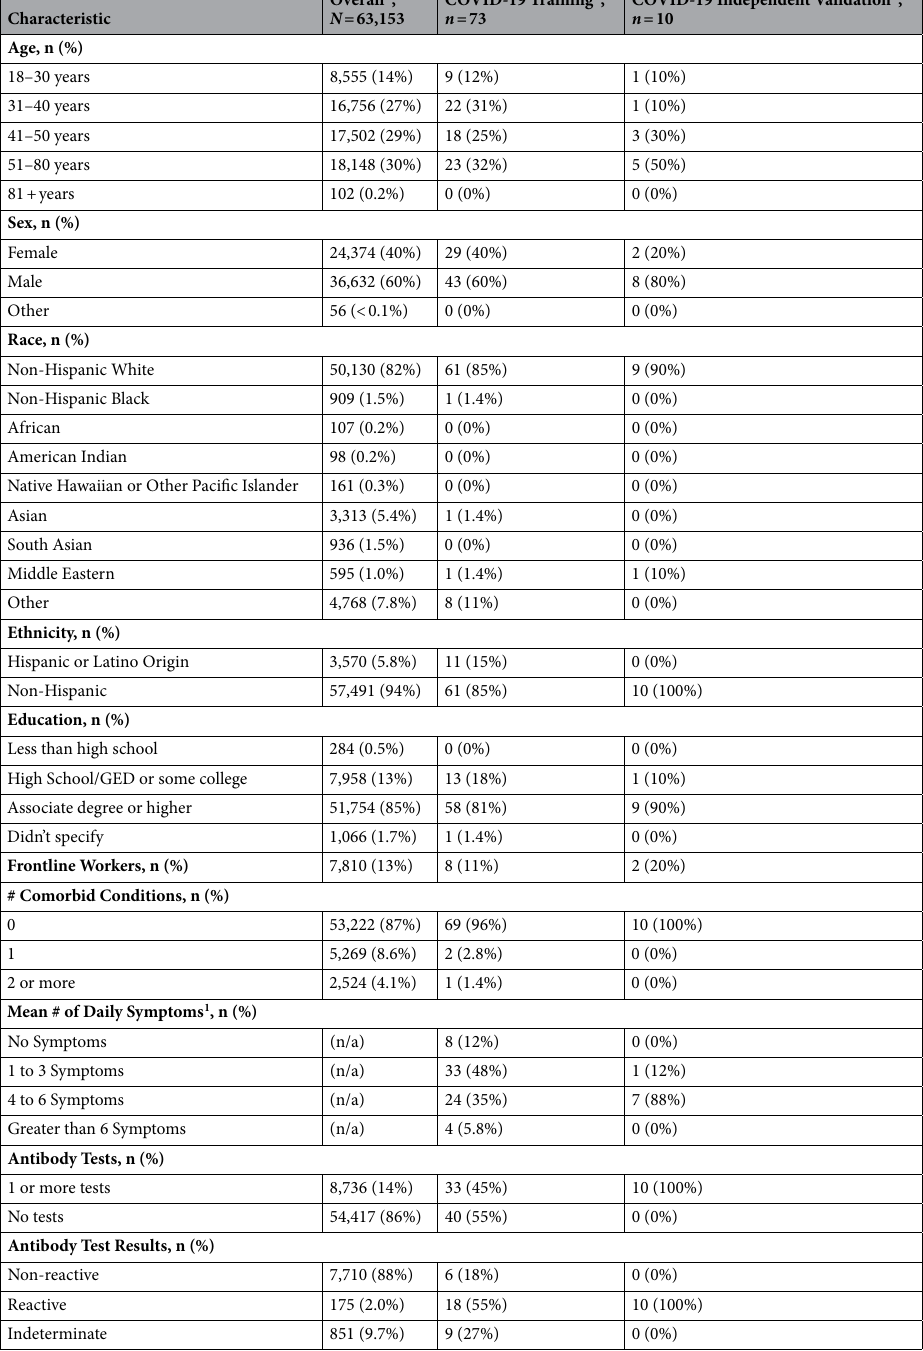
Table 1. Participant characteristics. *n (% of non-missing). 1 mean number of daily symptoms were computed for period spanning 3 days before to 3 days after the diagnosis date (for participants with a confirmed diagnosis). In the overall sample, n = 61,063 had available age data; n = 61,062 had available sex data, education data, and frontline worker status data; n = 61,017 had available race data; n = 61,061 had available ethnicity data; and n = 61,015 had available comorbid condition data. Within COVID-19 training data, n = 72 had available data for age, sex, race, ethnicity, education, frontline worker status, and comorbid conditions; n = 69 had available data for symptoms. Within COVID-19 independent validation data n = 8 had available data for symptoms; n = 10 had available data for all other